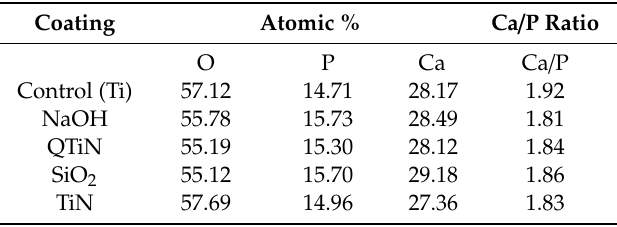
Figure 4. Representative EDX. Energy dispersive analysis x-ray of the quaternized titanium nitride sample is representative of what all the sample EDX graphs looked like. Table 3. Atomic percentages (O, P, Ca) from EDX and atomic ratio of Ca/P.